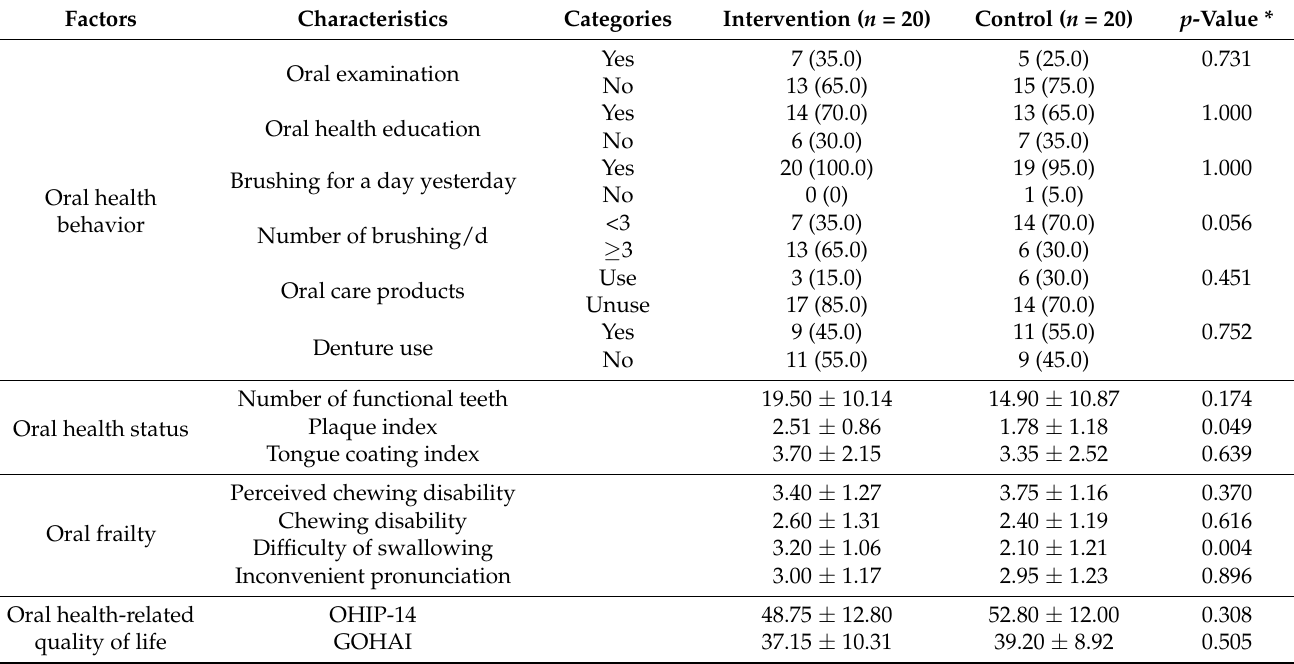
Table 2. Homogeneity of oral health and dietary factors between the intervention and control